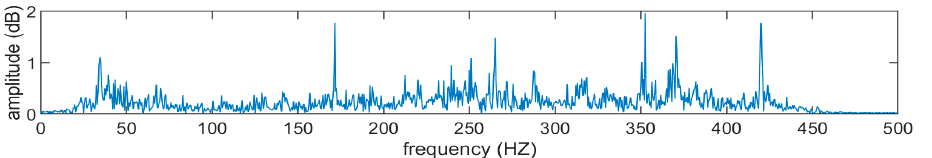
Figure 15. Frequency spectrum of random noise of the actual micro-seismic data.